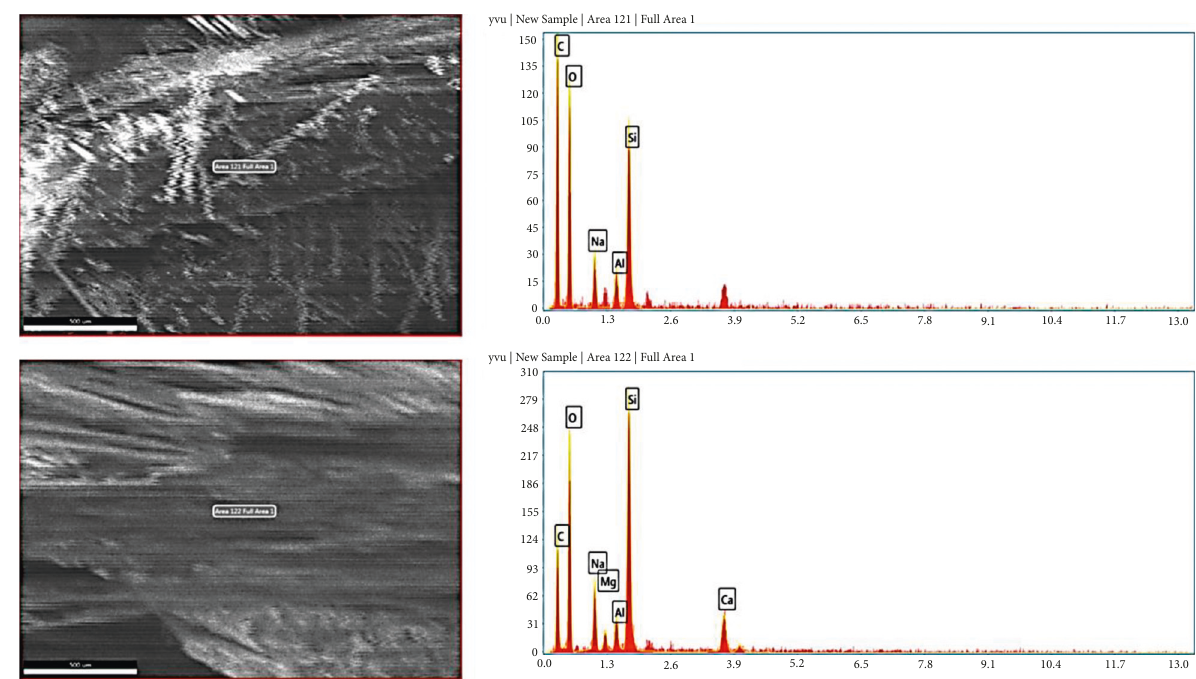
Figure 11: EDS of solid jet abrasion test nanocarbon powder-filled